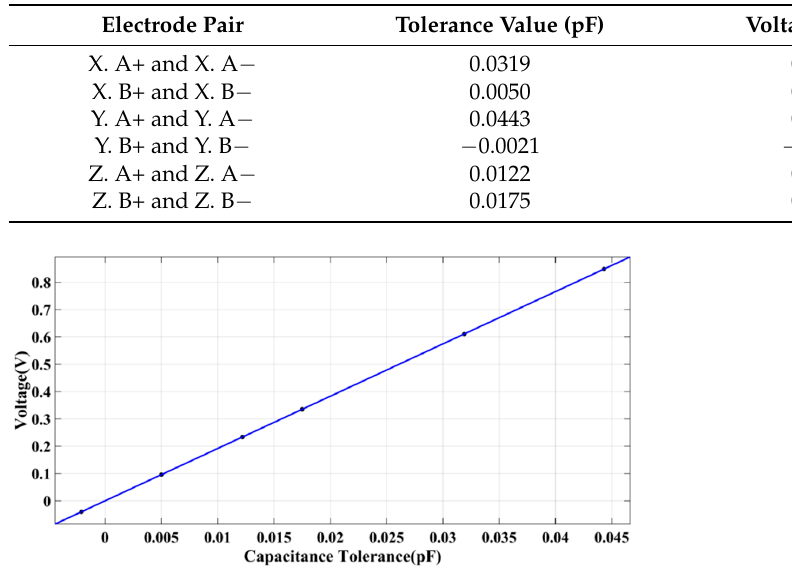
Table 4. Sensitive structure: six pairs of electrode capacitance tolerance and capacitance sensing system readout voltage.